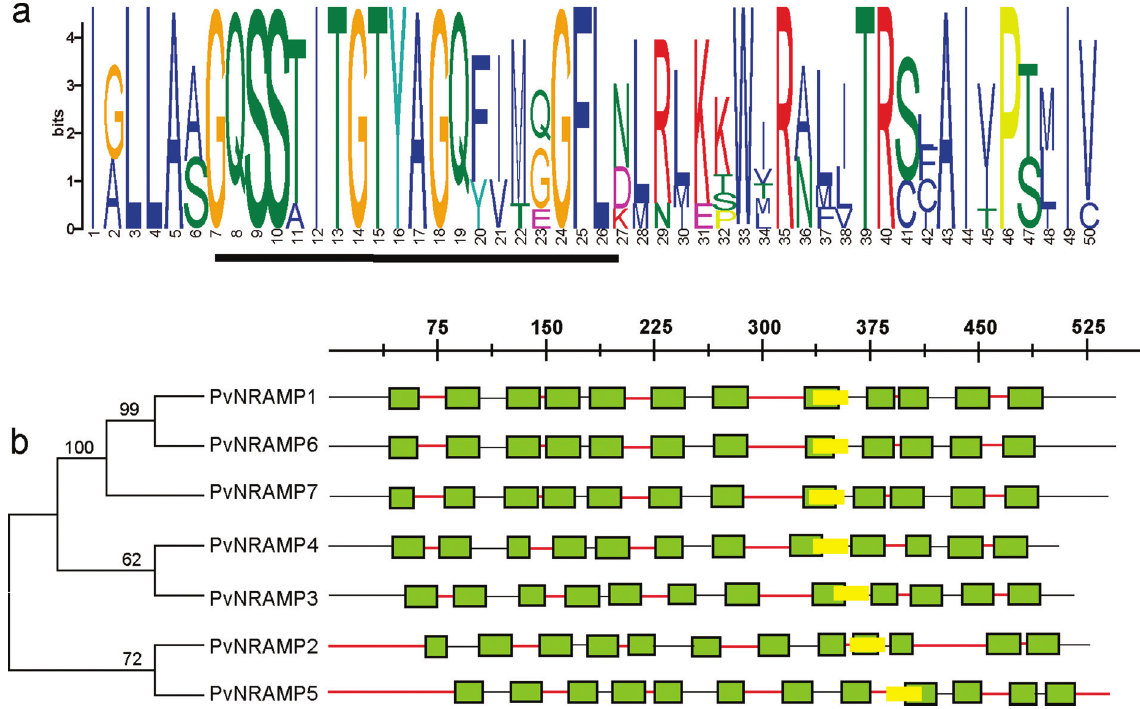
Figure 1 - Diagrammatic representation of architecture of the NRAMP putative protein in P. vulgaris . (a) The conserved motif graph generated by the MEMEprogram,displayedbystacksoflettersateachsite.Theconservedaminoacidismarkedbyayellowboxatthebottomofstackedletters.(b)Sche- matic view of transmembrane domain (TM) (green), the extracellular and intracellular portions are represented in black and red lines, respectively. Con- served motif between TM 8 and 9 is shown in yellow. The scale is set to the number of amino